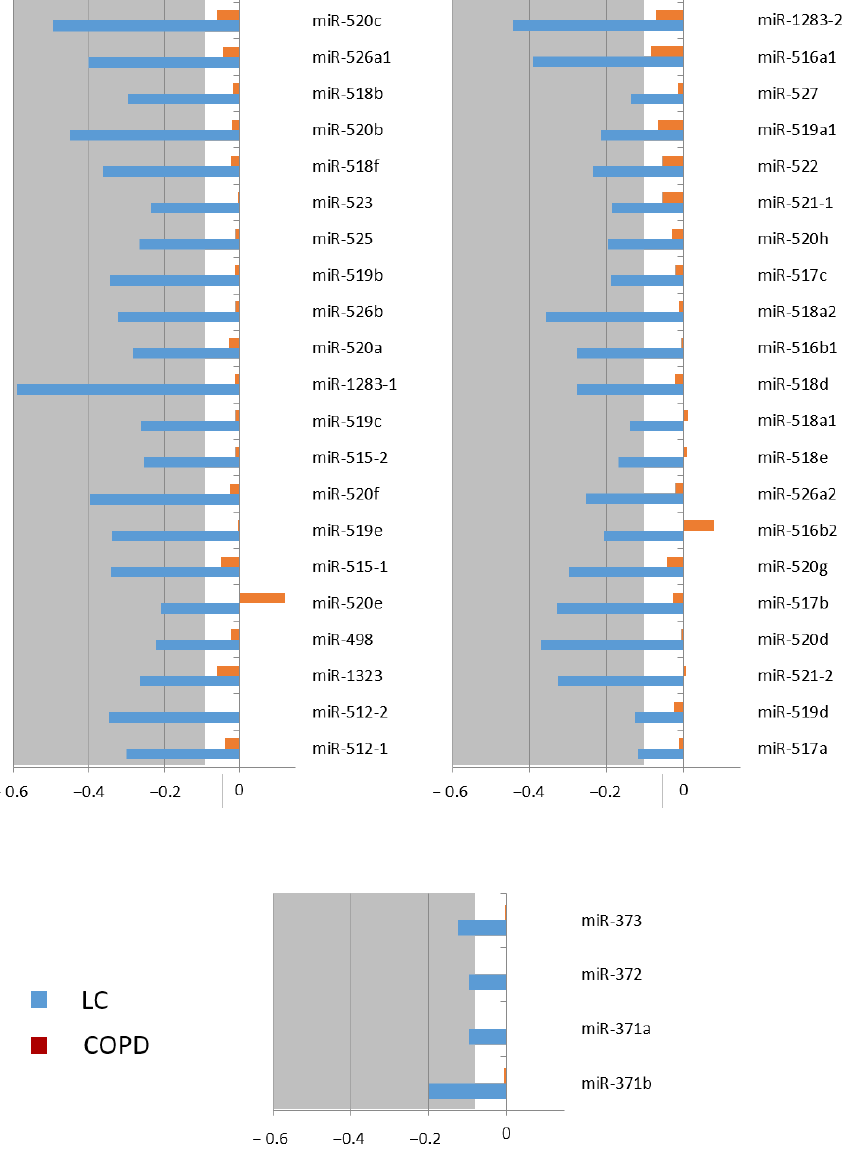
Figure 1. Methylation profiles of the C19MC and MIR371-3 miRNA clusters in lung cancer. ( A ) Circos plot showing the methylation levels on chromosome 19. From inside to outside: methylation levels, ideogram and gene labels. Hypermethylation (red dots and green background) and hypomethylation events (green dots and red background) in patients with lung cancer versus paired non-tumoral samples. NA: Not available. ( B ) Observed methylation changes (log 2 ratio) in the C19MC cluster. Relative levels of methylation in patients with lung cancer relative to the control group are represented in blue bars, whereas methylation levels of COPD patients without lung cancer compared to the non-tumoral control group are represented by red bars. A grey background represents statistically significant differences (adjusted p -value < 0.05) of methylation levels relative to the control group. ( C ) Observed methylation changes (log 2 ratio) in the MIR371-3 cluster. Relative levels of methylation in patients with lung cancer relative to the control group are represented in blue bars, whereas methylation levels of COPD patients without lung cancer compared to the non-tumoral control group are represented by red bars. A grey background represents statistically significant differences (adjusted p -value < 0.05) of methylation levels in comparison to the non-tumoral control